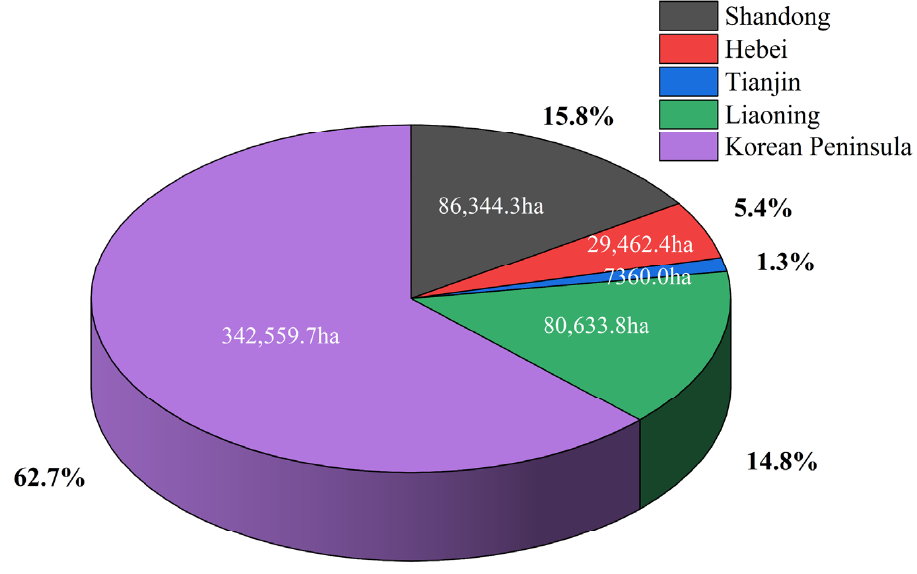
Figure 5. Area statistics of tidal flats around the Bohai and Yellow Seas. To display the tidal flats around the Bohai and Yellow seas intuitively, the tidal flats map was overlaid on the administrative boundary and Sentinel-2 lowest tide images (Figure 6). The lowest tide images during Oct 2020 to Oct 2021 were selected on the GEE platform. With the help of a filter function integrated in GEE, all time-relative and geolocation-relative images were stacked in image collections and visually checked to find the lowest tide images. As illustrated in Figure 6, the outline and shape of our tidal flat map achieved strong agreement with the lowest tide images. It should be noted that the turbid water clearly presented in Figure 6a–c,e was not wrongly classified as tidal flats. Additionally, in Figure 6b,c,e, the tidal flat map did not cover the entire area of those outside the artificial boundaries. That is because they were not inundated by sea water during the study period, although the geological features of those areas are similar to tidal flats.